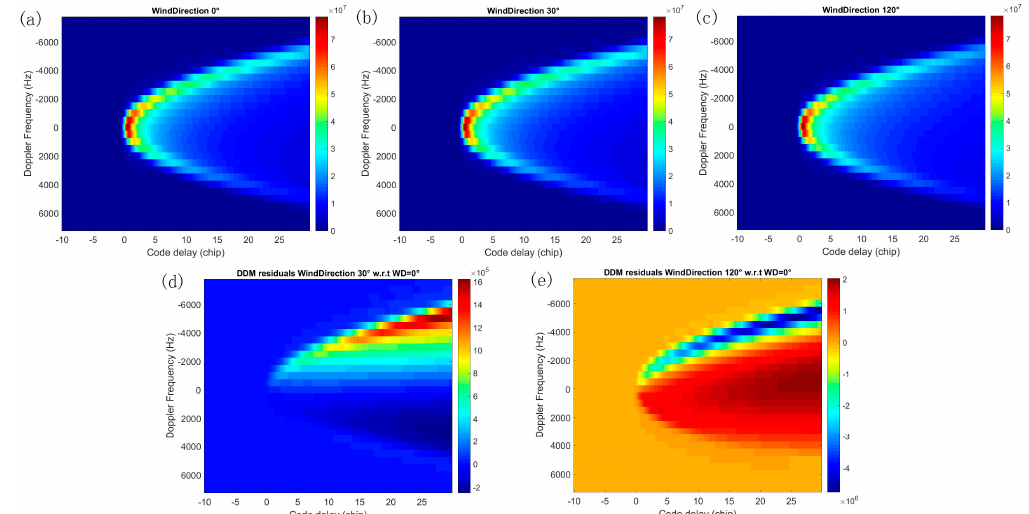
Figure 4. DDM simulations under different wind direction ( a ) 0°; ( b ) 30°; ( c ) 120°. DDM differences w.r.t. the DDM of wind direction 0°. ( d ) The DDM residual of wind direction of 30°; ( e ) The DDM residual of wind direction of 120°. The wind speed, elevation and azimuth of the receiver are 10 m/s, 60°, and 30°.